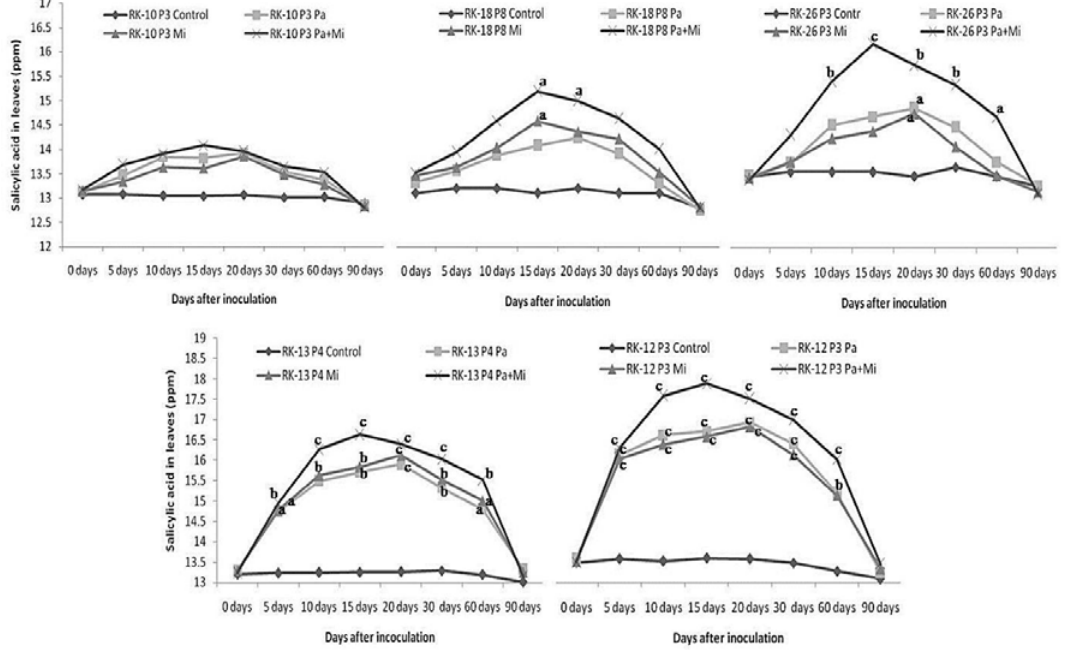
Figure 2. Mean amounts of salicylic acid in leaves of five tobacco cultivars 0–90 days after inoculation singly or concomi - tantly with Meloidogyne incognita (Mi) or Pythium aphanidertmatum (Pa). Values followed by a ( P≤ 0.05), b ( P≤ 0.01) and c ( P≤ 0.001) are significantly different from the